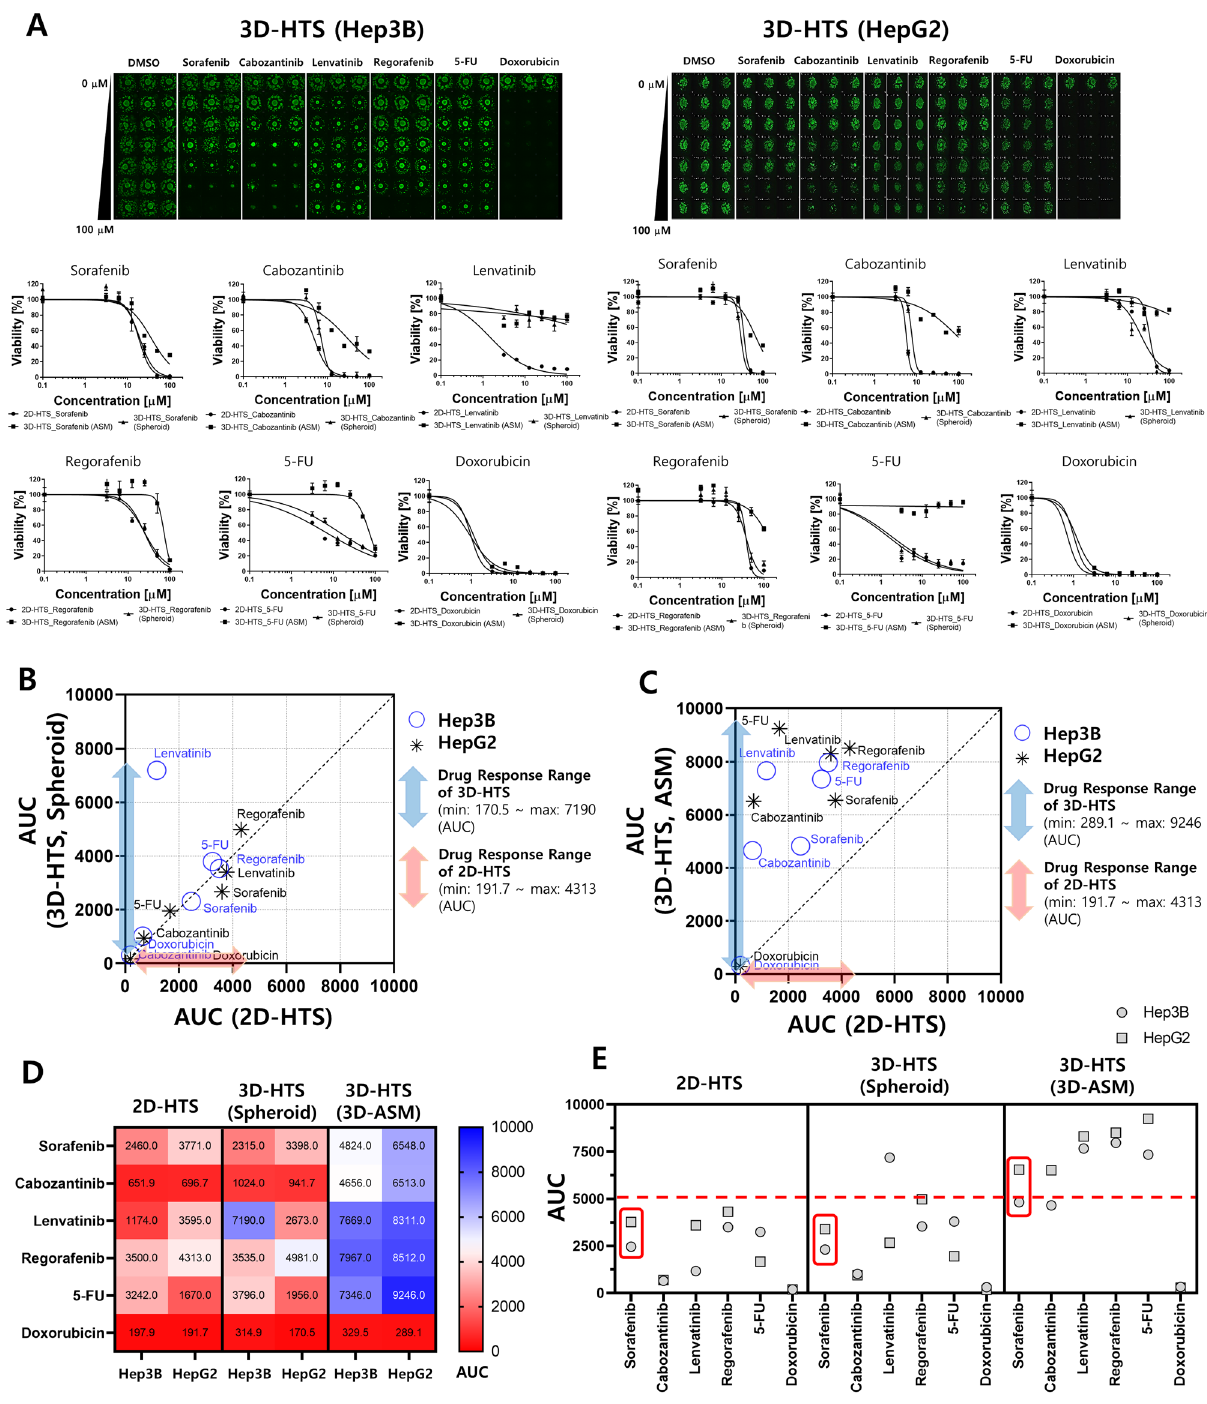
Figure 5. Confirmation of high drug efficacy analysis performance of 3D-HTS platform through comparison of HTS results. ( A ) Live cell images (3D-ASM). Dose–response curves (DRCs) of 2D-HTS and 3D-HTS (ASM and spheroid) by drug for two HCC cell lines (Hep3B and HepG2). ( B ). Comparative analysis of drug response according to AUC values based on 2D-HTS and 3D-HTS (spheroid and ASM). ( C ). Comparative analysis of drug response according to AUC values based on 2D-HTS and 3D-HTS (spheroid and ASM). ( D ). Comparative heatmap analysis of drug response based on AUC value. E. Comparative analysis of drug response based on AUC values according to the drug screening model. 2D-HTS and 3D-HTS (spheroid) showed a sensitive response to all drugs, and thus had low selectivity to the